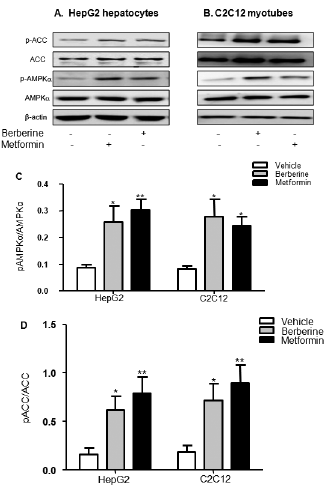
Figure 5. Effects of berberine on phosphorylation of AMPK and ACC. HepG2 hepatocytes (A) and C2C12 myotubes (B) were treated with 20 m mol/L berberine or 10 mmol/L metformin for 24 h after serum starvation in DMEM with 0.25% BSA and 15 mM D-glucose. Western blot was performed with the whole cell lysate. Stimulation of AMPK and ACC phosphorylation was quantified as relative optical density (C and D). Results are shown as means 6 SEM from at least six independent experiments; * P , 0.05 and ** P , 0.01 vs .